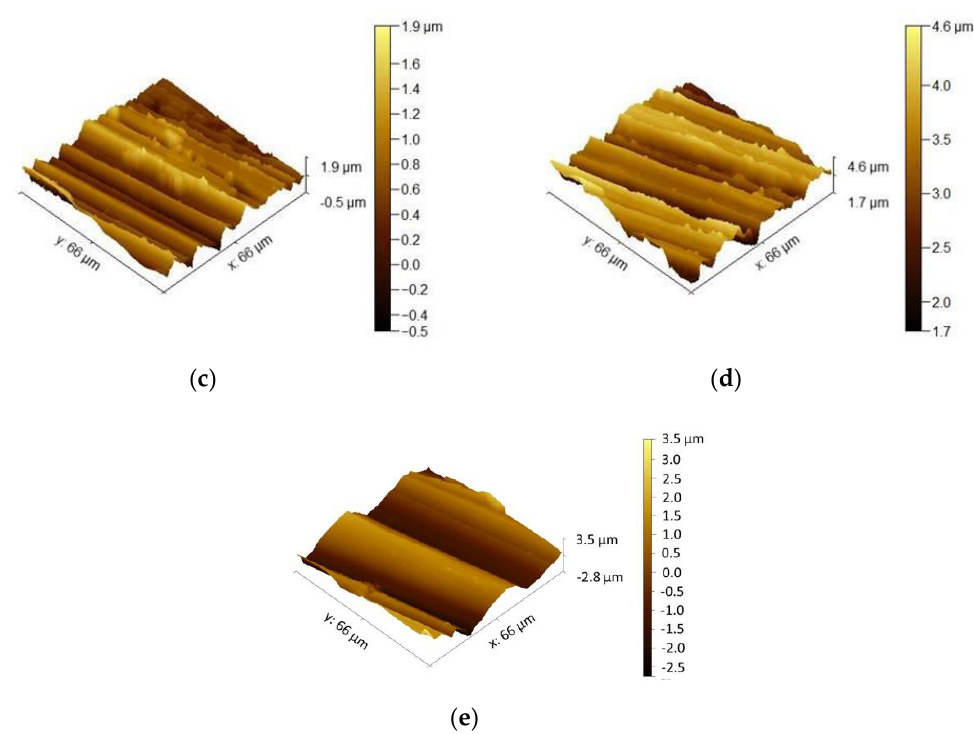
Figure 11. Images showing surface topography of Ni-14Cr-4Al model alloy with: ( a ) polished up to 1 µm diamond paste; ( b ) Ground using 1200 grit sand paper; ( c ) Ground using 500 grit sand paper; ( d ) Ground using 220 grit sand paper; ( e ) Ground using 80 grit sand paper.